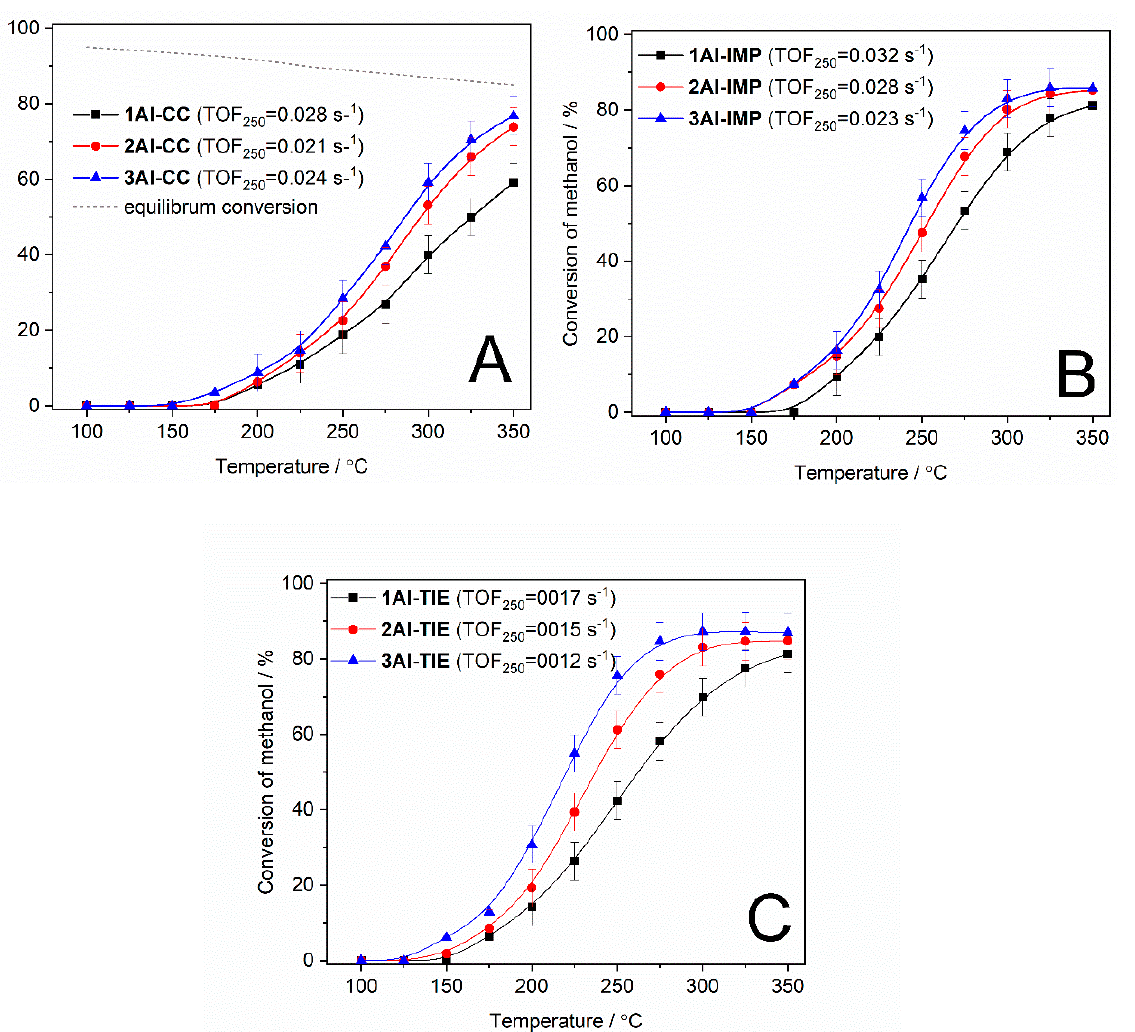
Figure 5. Results of the catalytic tests in the reaction of methanol to DME dehydration in the presence of MCM-41 modified with aluminum by the co-condensation ( A ), impregnation ( B ), and TIE ( C ) methods.